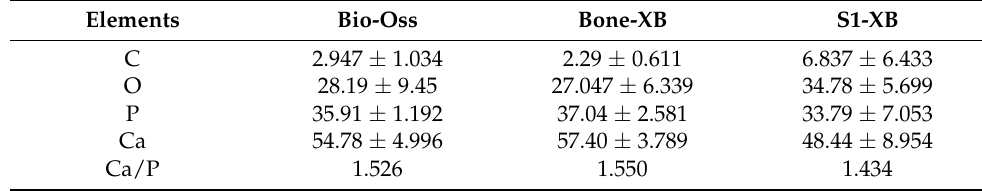
Table 3. EDS results of the bone substitutes (Atomic %; Mean ±